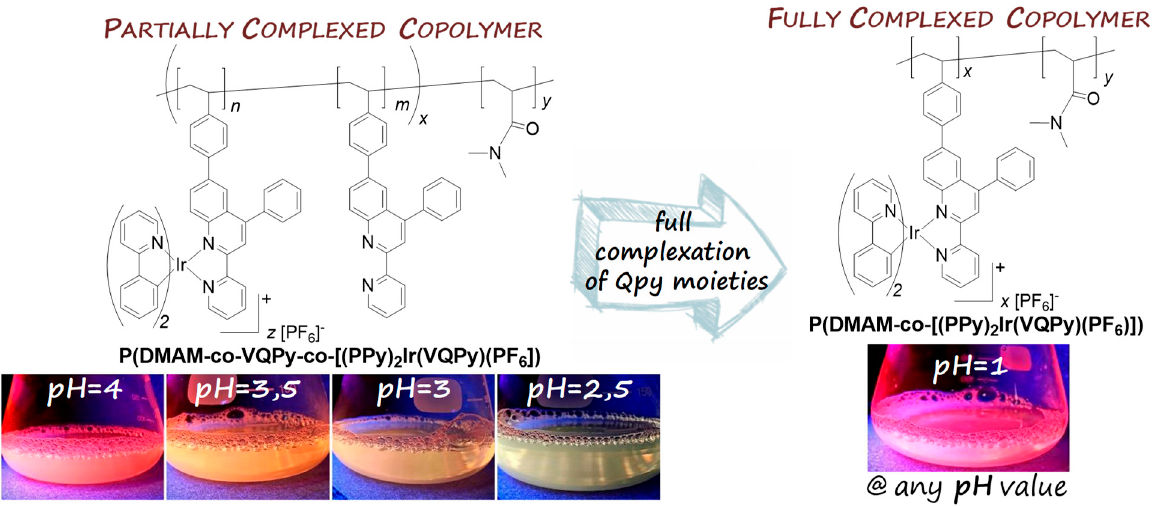
Figure 6. Demonstration of the pH induced color changes of aqueous solutions of copolymer P(DMAM-co-VQPy-co-[(PPy) 2 Ir(VQPy)(PF 6 )]) P2 and of the persistent red color of the P2 copolymer bearing only Ir(III)-complexed VQPy moieties. All solutions are shown under UV illumination at 365 nm.